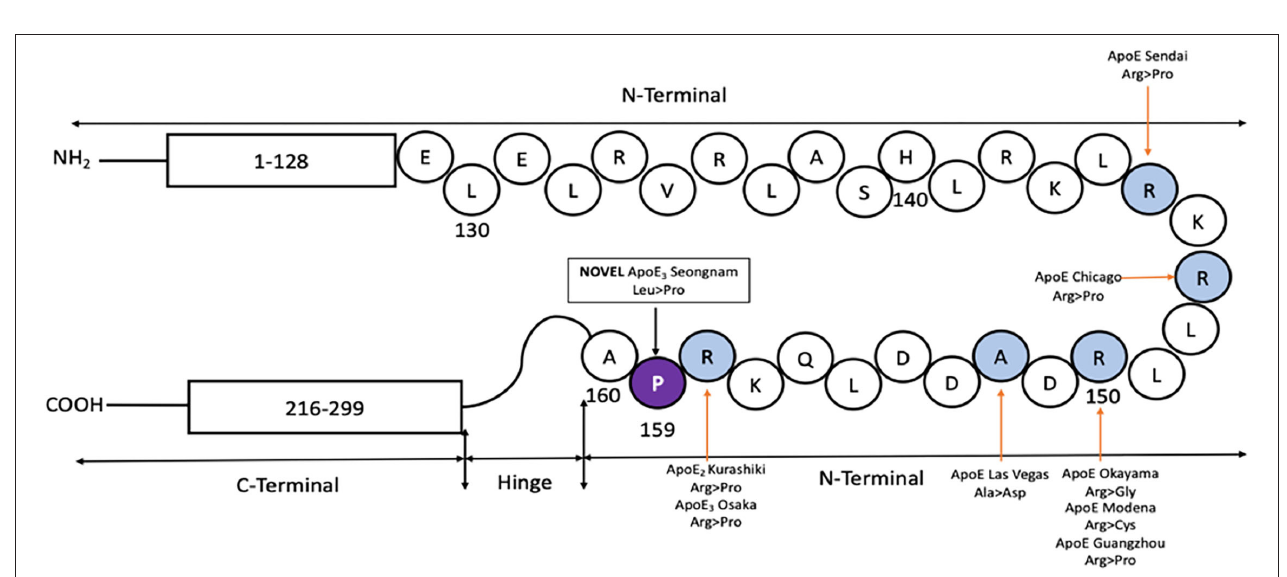
FIGURE 6 | Protein map of APOE, showing the N and C terminal connected with a hinge. Previously reported mutations in the LDLR site (shaded in blue) are shown, along-with the novel APOE3 Leu159Pro (shaded in violet with the mutated codon) found in a Korean male patient with EOAD.